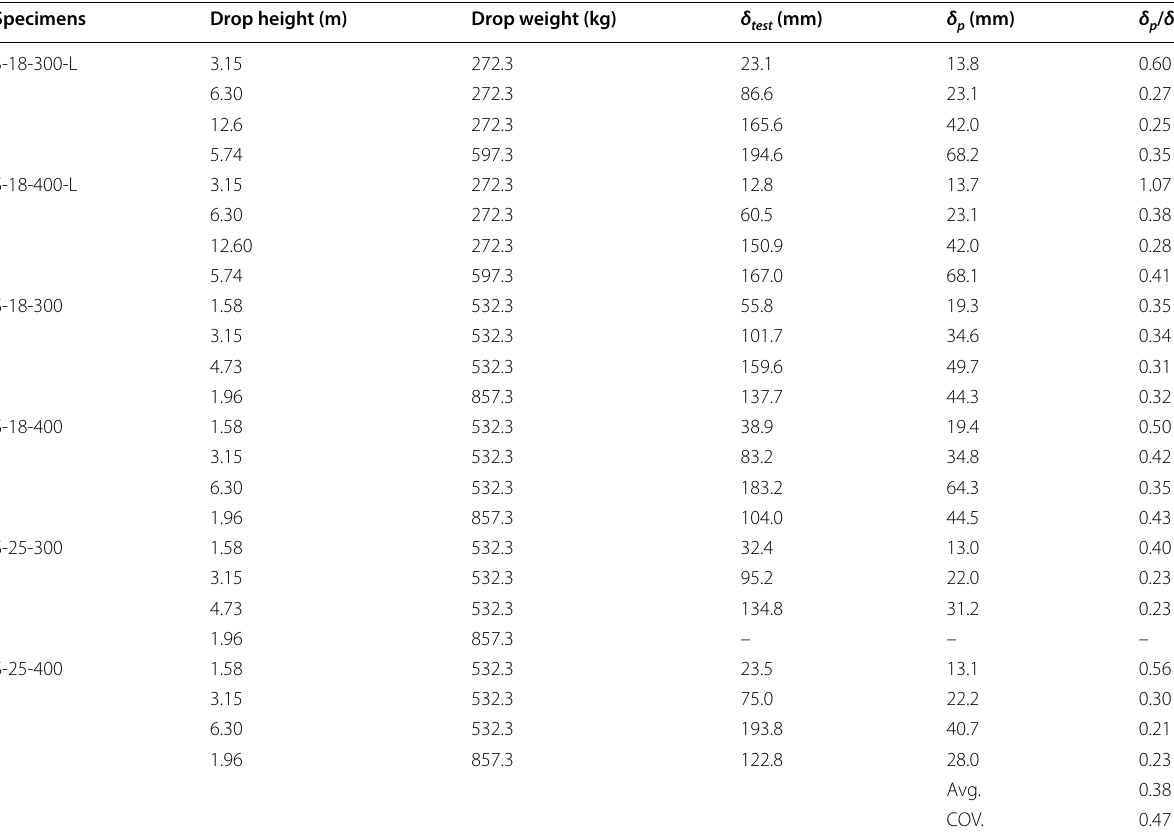
Table 5 Comparison of peak deflection in test with predicted